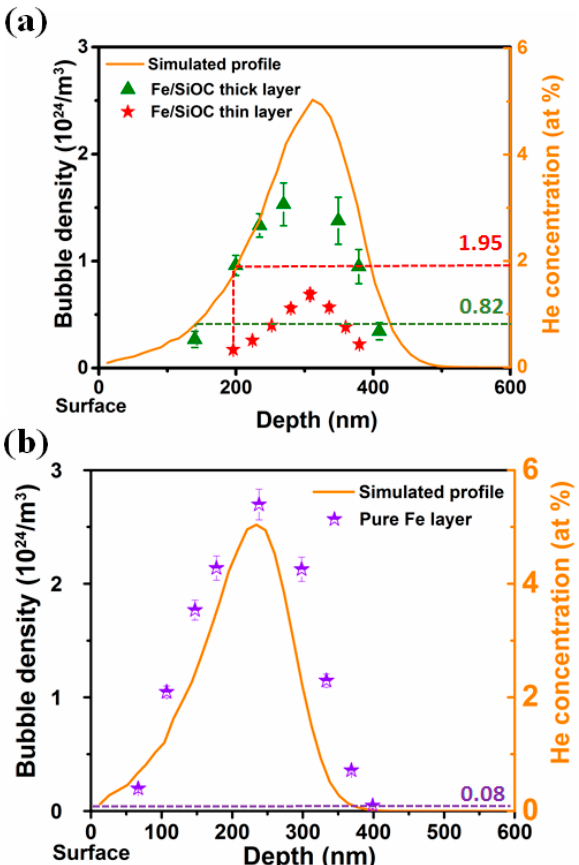
Figure 4. He bubble density (scattered points) as a function radiation depth in ( a ) Fe/SiOC multilayer and ( b ) pure Fe films. Solid line in each figure is simulated helium depth profile. The dashed line was drawn to help estimate the threshold concentration for the formation of detectable He bubbles. Bubble density in Fe layers of Fe/SiOC multilayers is significant lower than that in pure Fe film.